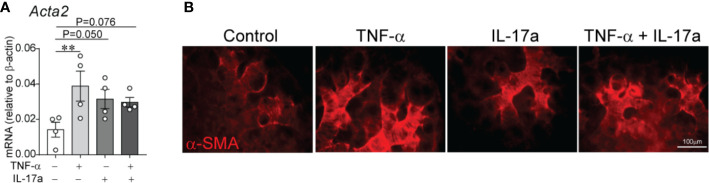
In E16 fetal mouse lung explants, TNF-α and IL-17a induce α-smooth muscle actin expression in the distal airspaces. E16 fetal mouse lung explants were microdissected and cultured in vitro in a transwell system on air–liquid interface in the presence or absence of recombinant mouse TNF-α (50 ng/ml), IL-17a (100 ng/ml) or both for 72 h. Control explants were cultured in serum free medium. This period corresponds to early saccular stage of lung development. Subsequently, lung explant tissue was analyzed for α-smooth muscle actin expression by qPCR (A) and immunostaining (B). (A) Data are shown as mean ± SEM; **P < 0.01 by unpaired t-test.